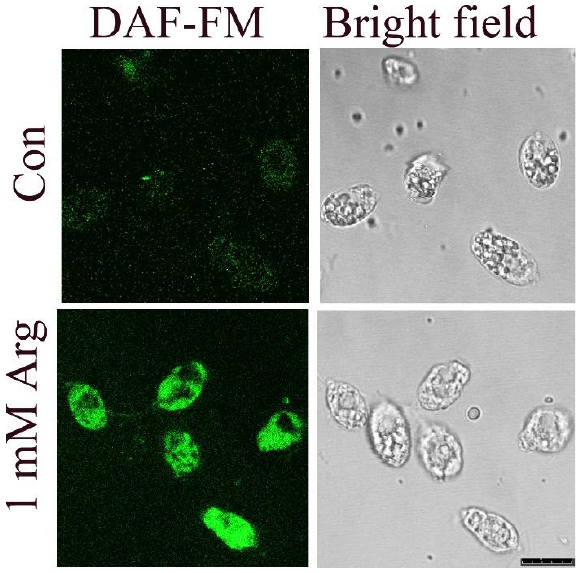
Figure 2. NO visualization in P. parva by confocal microscopy. Images of cells grown in ammonium- containing medium (Con) and then incubated with 1 mM arginine for 0.5 h. The left-hand panels show DAF-FM fluorescence (green color), while the right-hand panels show bright field images. Scale bar equals 10 μ m.